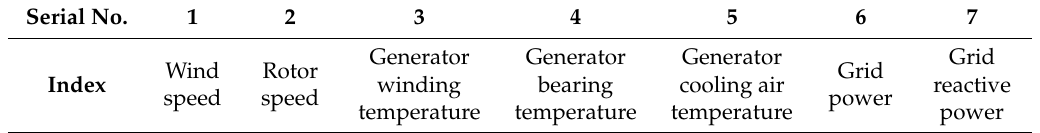
Table 3. Generator fault related parameter indicators.